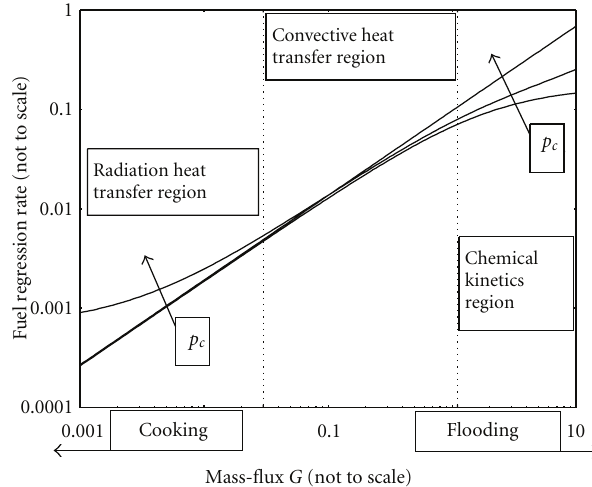
Figure 2: Typical regression rate